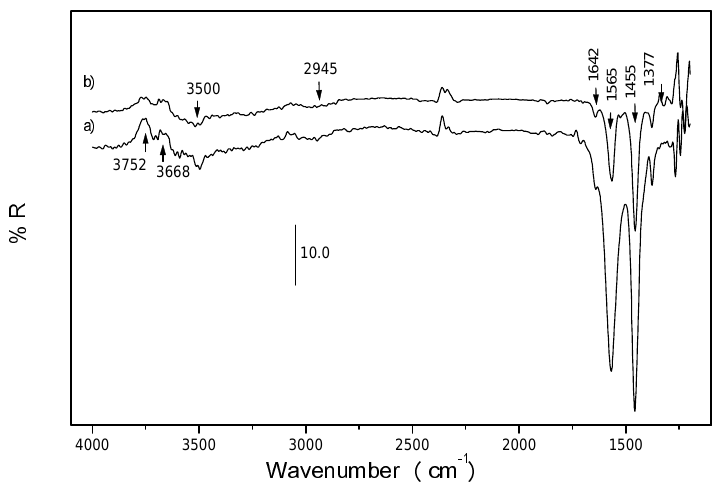
subtracted) of 1.5 wt % 2 H + 5 % O , b) subsequent incorporation of 3 6 2